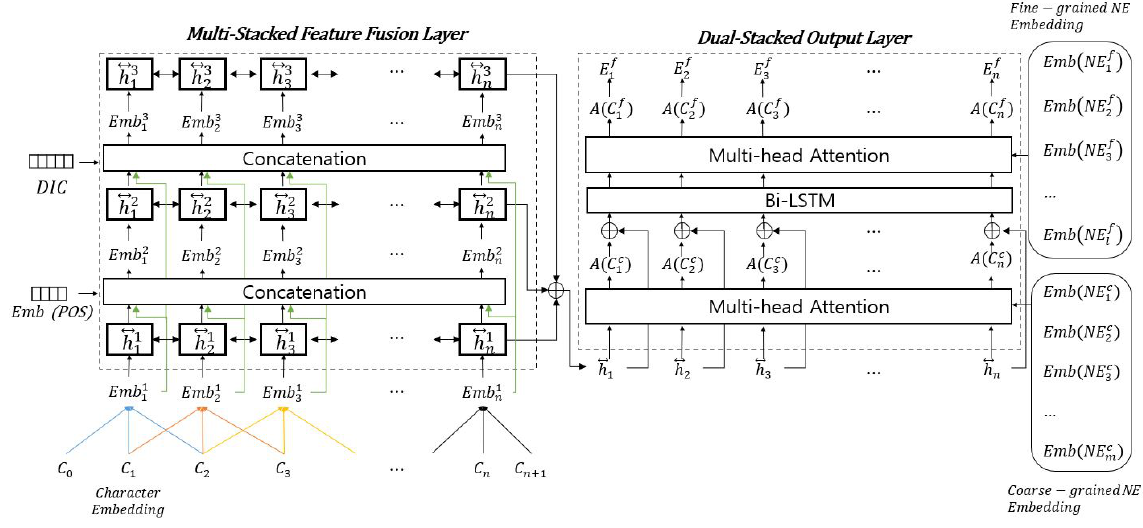
Figure 1. Overall architecture of